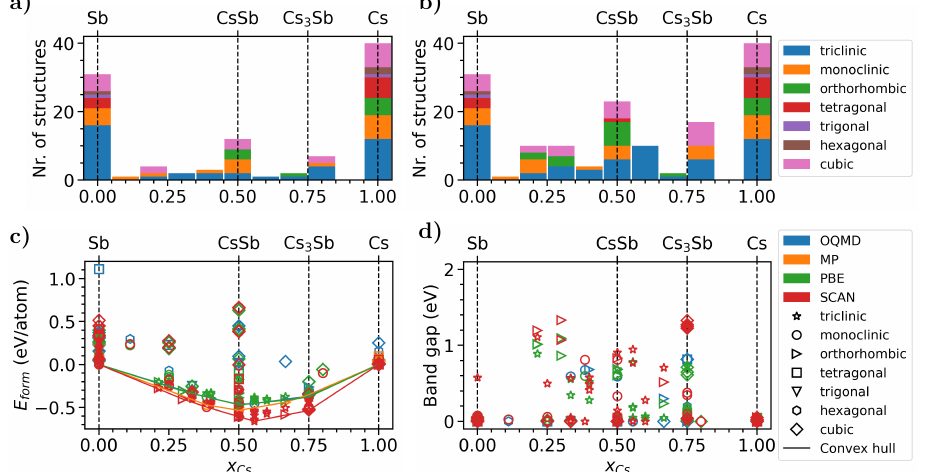
Figure 7. Histogram of the number of cesium–antimonide structures ( a ) mined directly from MP and OQMD and ( b ) generated from chemically analogous structures upon exchange of anions and cations (details in the text); ( c ) formation energy ( E form ), including the convex hull, and ( d ) band gap of the identified structures depending on the concentration of Cs, as taken directly from the databases (OQMD and MP) and recalculated in this work with the PBE and SCAN functionals (see color and symbol codes in the